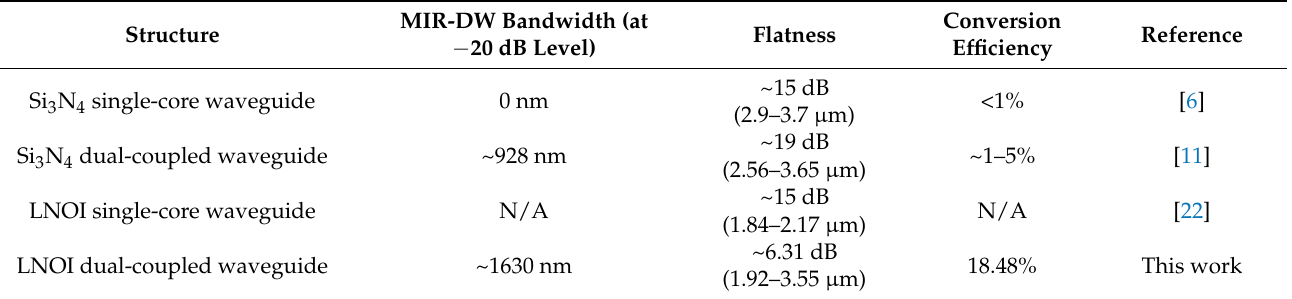
Table 1. The comparison of the spectral bandwidth, flatness, and conversion efficiency with some previous